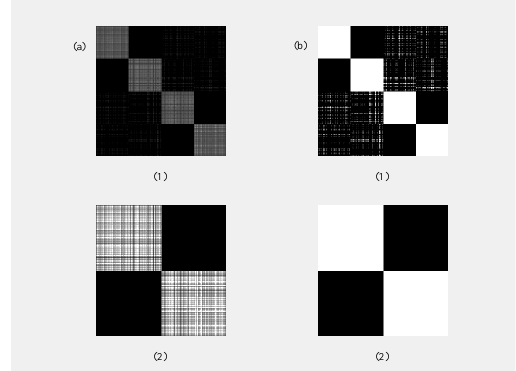
Figure 3. Kernel matrices for XOR dataset before and after kernel-based metric learning algorithms. (1) initial kernel matrix used in metric learning, (2) learned kernel matrix in metric learning process. (a) kernel-  , (b) unweighted- SD .